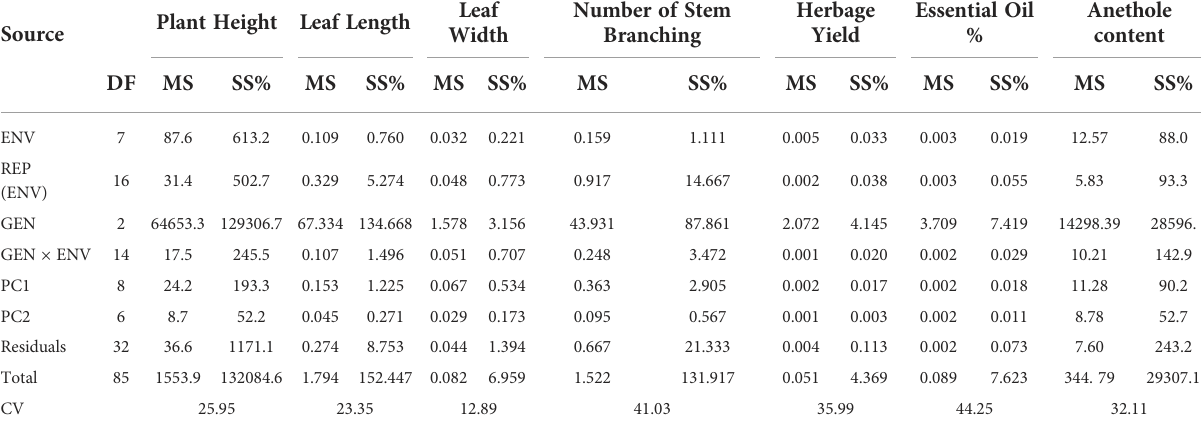
TABLE 3 AMMI Analysis of variance for the seven traits in C. heptaphylla in MLT.